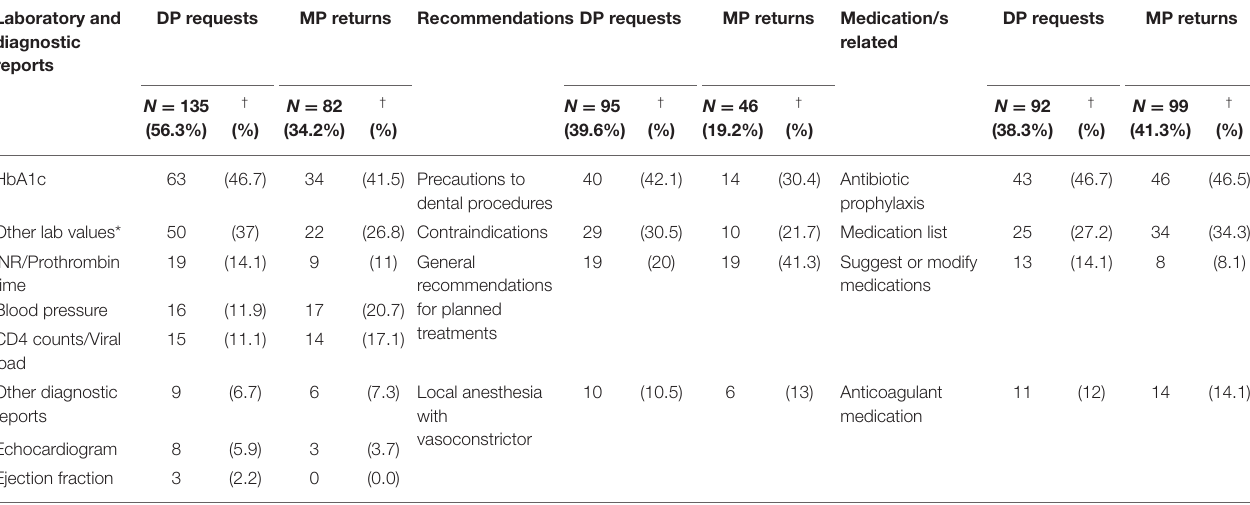
TABLE 3 | The specific types of information (aside from medical conditions), dental providers (DP) requested vs. medical providers (MP) returned within the 240 medical